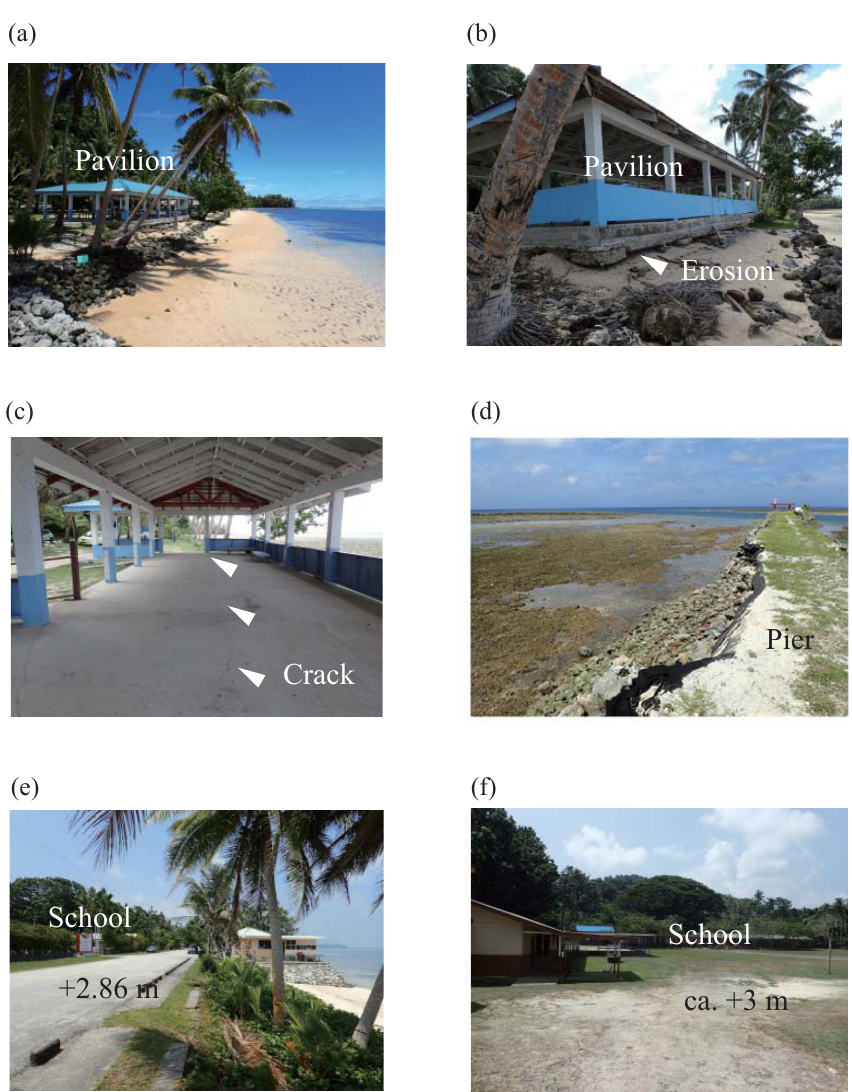
Figure 3. Photograph of the coast at the study site. (a) A pavilion located in the coast. The elevation of the pavilion is less than 3m above present m.s.l. (b) Damage of the foundation of pavilion due to the erosion during Typhoon Bopha. (c) Many cracks of the floor of the pavilion. (d) Photograph of the collapsed pier at Melekeok reef. (e) Photograph of the road and Melekeok elementary school along the coast. The elevation of the road is + 2.86m above present m.s.l. (f) Photograph of the ground of the school. The elevation of the ground is ca. 3m above present m.s.l. The road and the ground were flooded during Typhoon